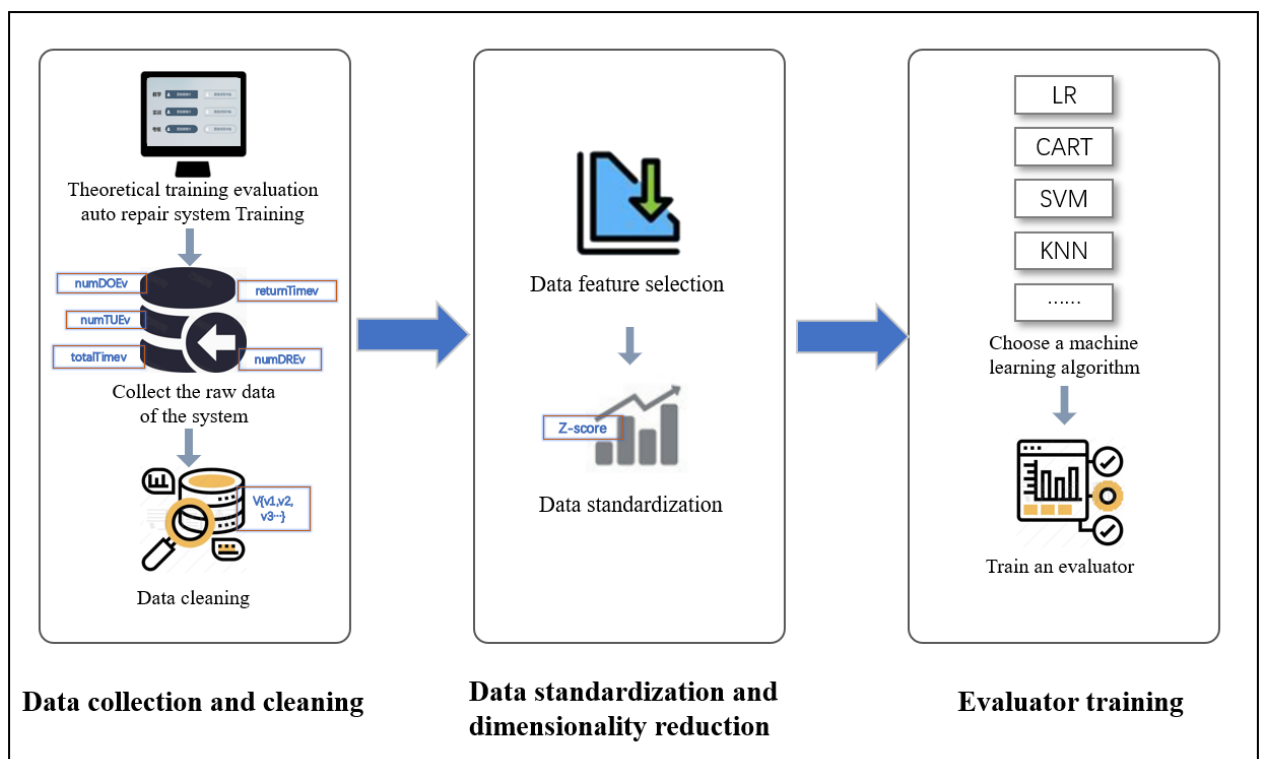
Figure 2. Schematic diagram of process evaluation data processing.